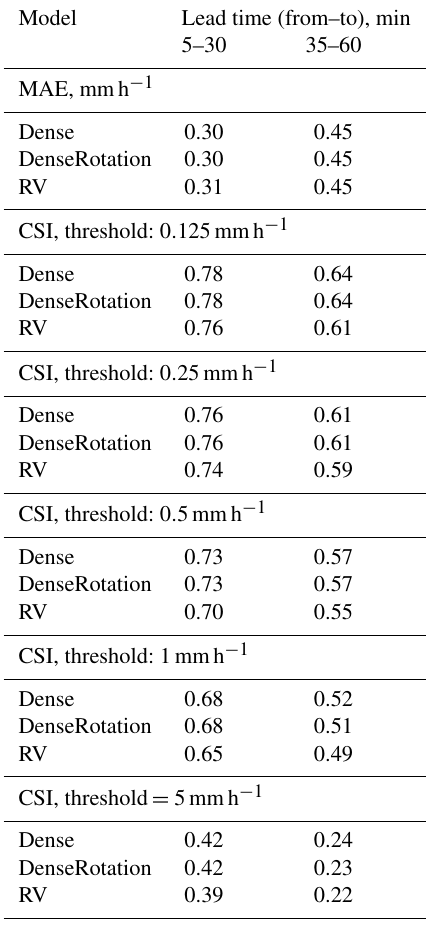
Table 3. Mean model metrics for different lead time periods